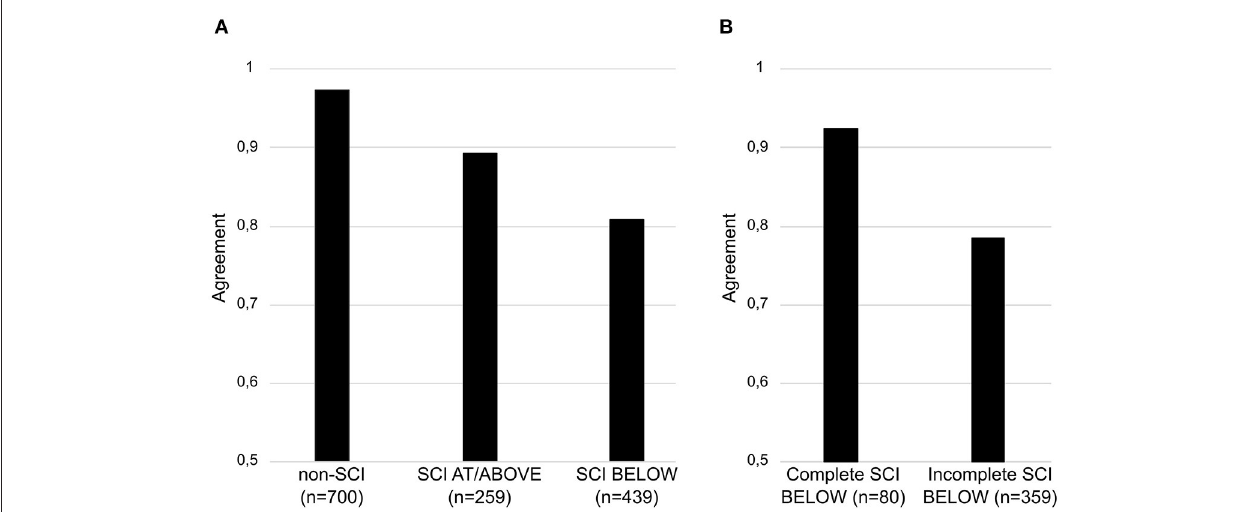
FIGURE 2 | Comparative results of percentage agreement for three raters. The results are illustrated for individuals without and with spinal cord injury (A) . In participants with spinal cord injury, results are illustrated for dermatomes AT/ABOVE and BELOW (A) the sensory level as well as for complete and incomplete lesions BELOW (B) the sensory level. The total number of dermatomes examined by three raters is stated as “ n ”. Agreement (vertical axis) is presented as decimal fraction of the percentage. SCI, spinal cord injury; SL, sensory level.